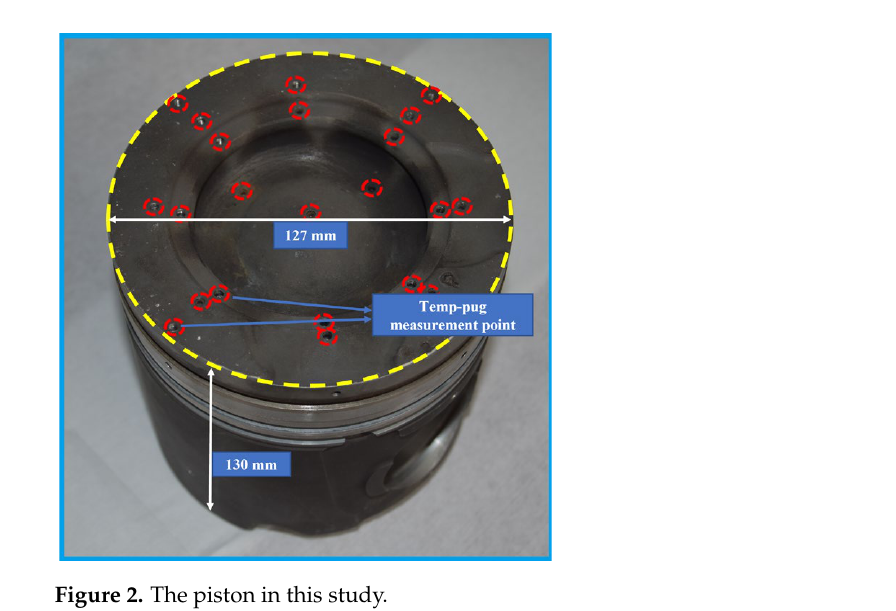
Figure 1. The scanning electron microscope picture of cross-sections of the coatings: ( a ) Mullite coating, ( b ) 8YPSZ coating [18].